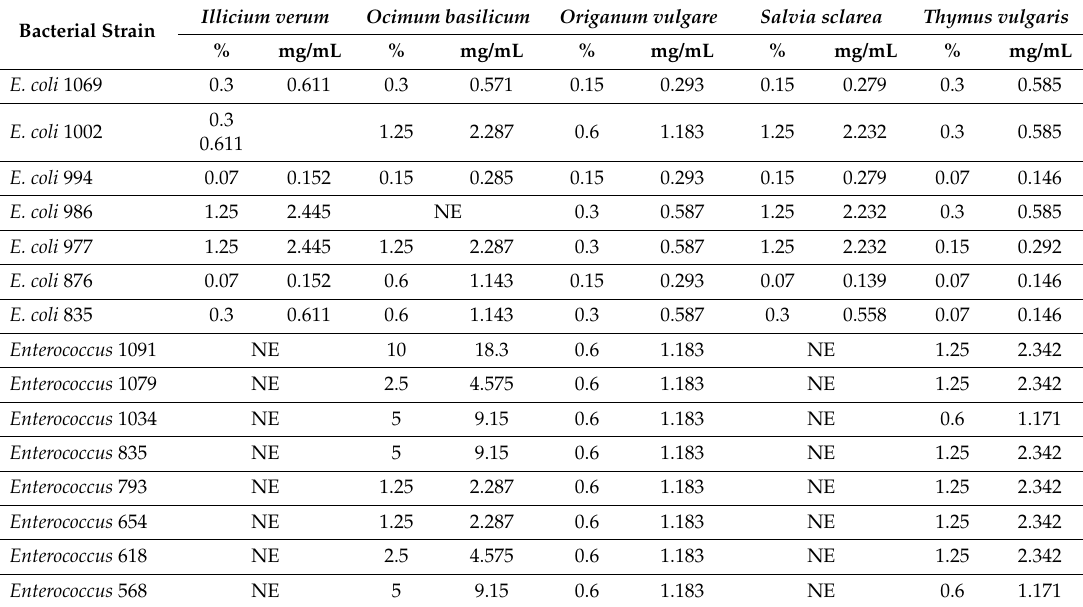
Table 4. Antibacterial activity expressed as minimum inhibitory concentration (MIC) of the essential oils against Escherichia coli and Enterococcus strains